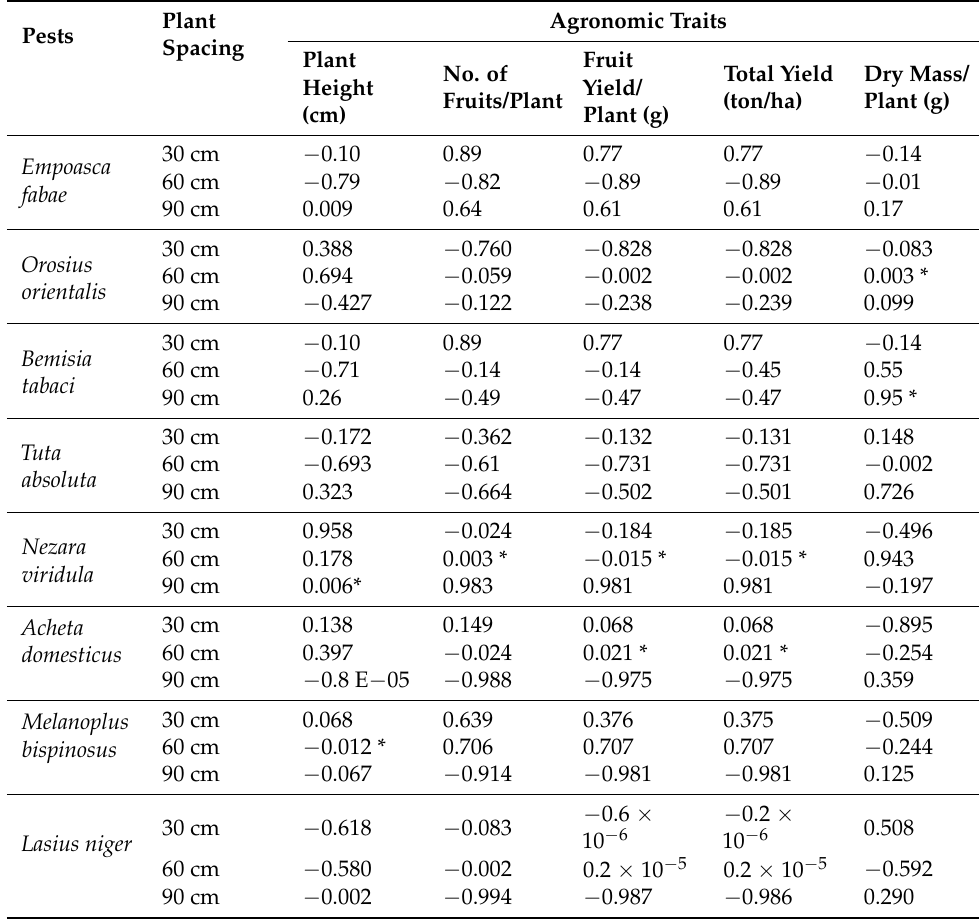
Table 5. Correlation (r) between the pest population and the agronomic traits in of the tomato variety ‘Tala F1’; the plants were grown at three different plant spacings (30 × 50 cm, 60 × 50 cm and 90 × 50 cm) during the winter season of 2020–2021. Plant Agronomic Traits Pests Spacing Fruit Plant Total Yield Dry Mass/ No. of Yield/ Height (ton/ha) Plant Fruits/Plant Plant (g) (cm)